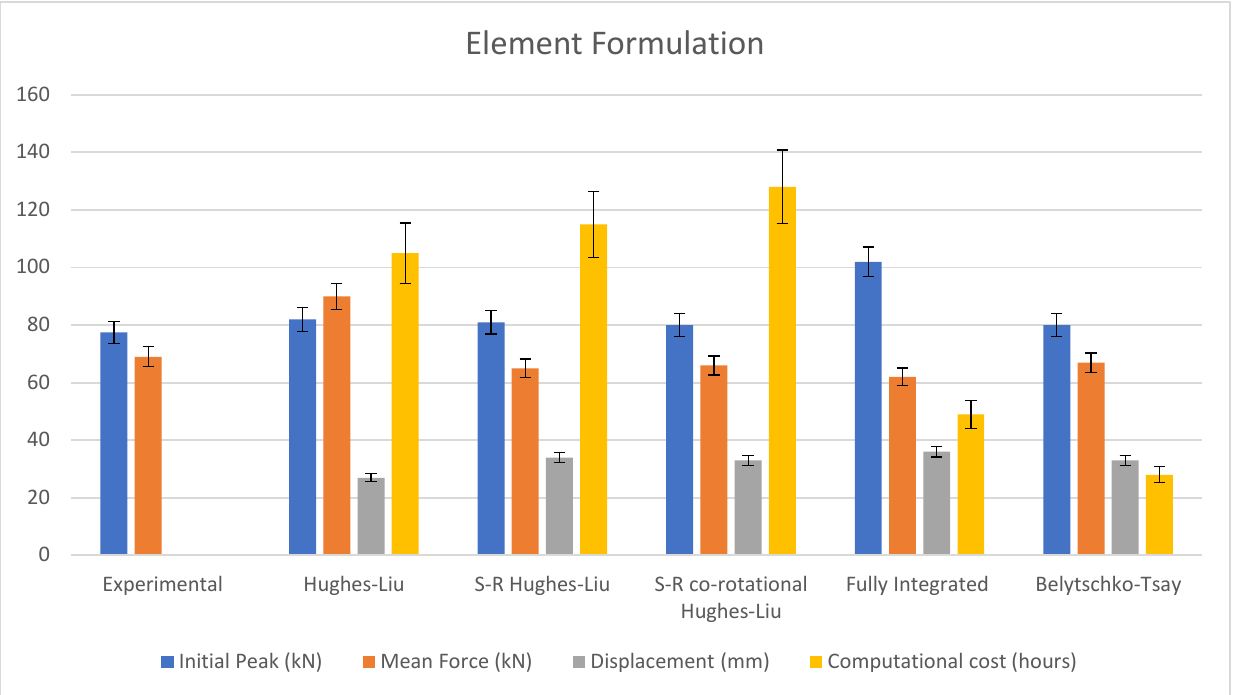
Figure 5. Element formulation comparison [66].